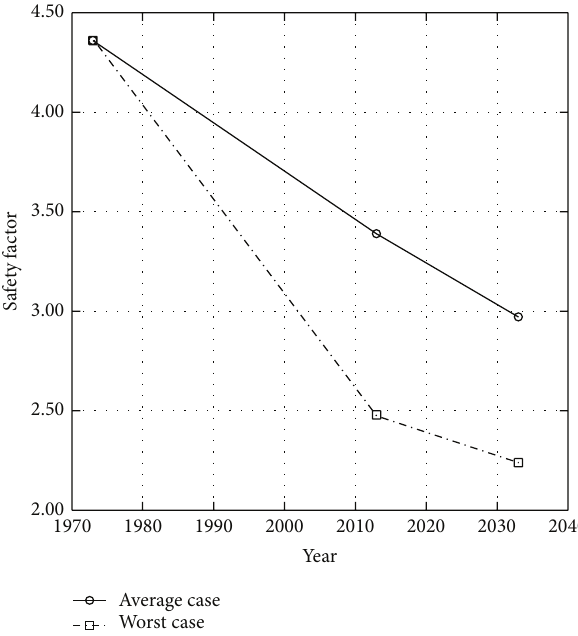
Figure 28: Safety factor for beam element with 500mm × 800 mm cross-section and shear reinforced with 2D12 mm diameter rebar with 150 mm spacing against